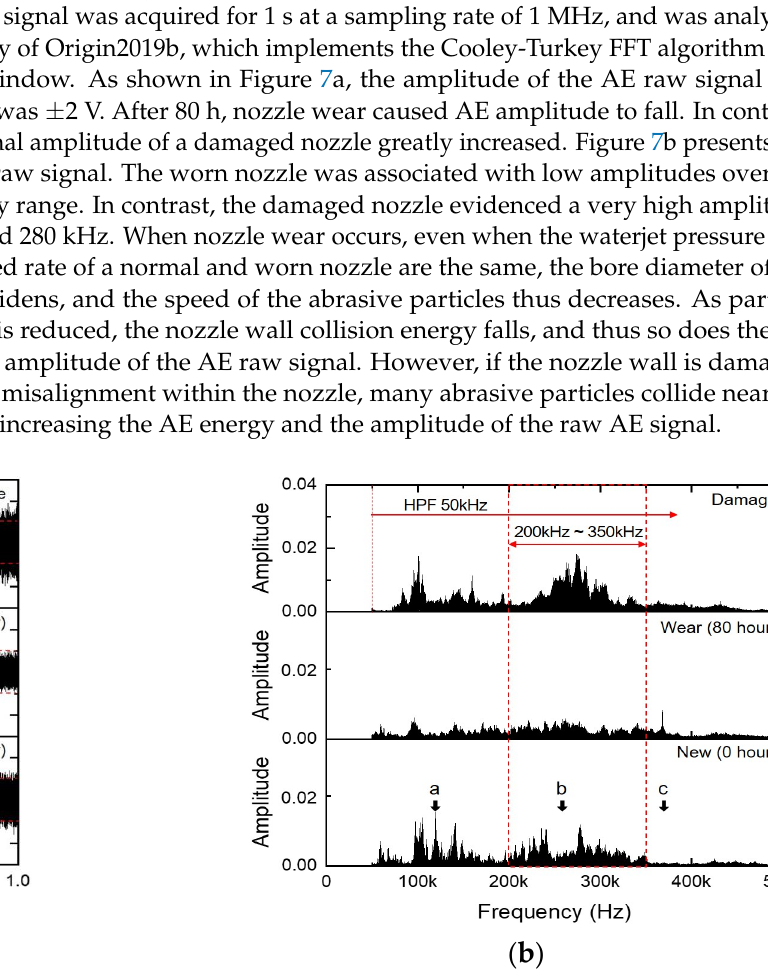
Figure 6. Photographs of parts by using normal and damaged nozzles: ( a ) normal part and ( b ) abnormal part.